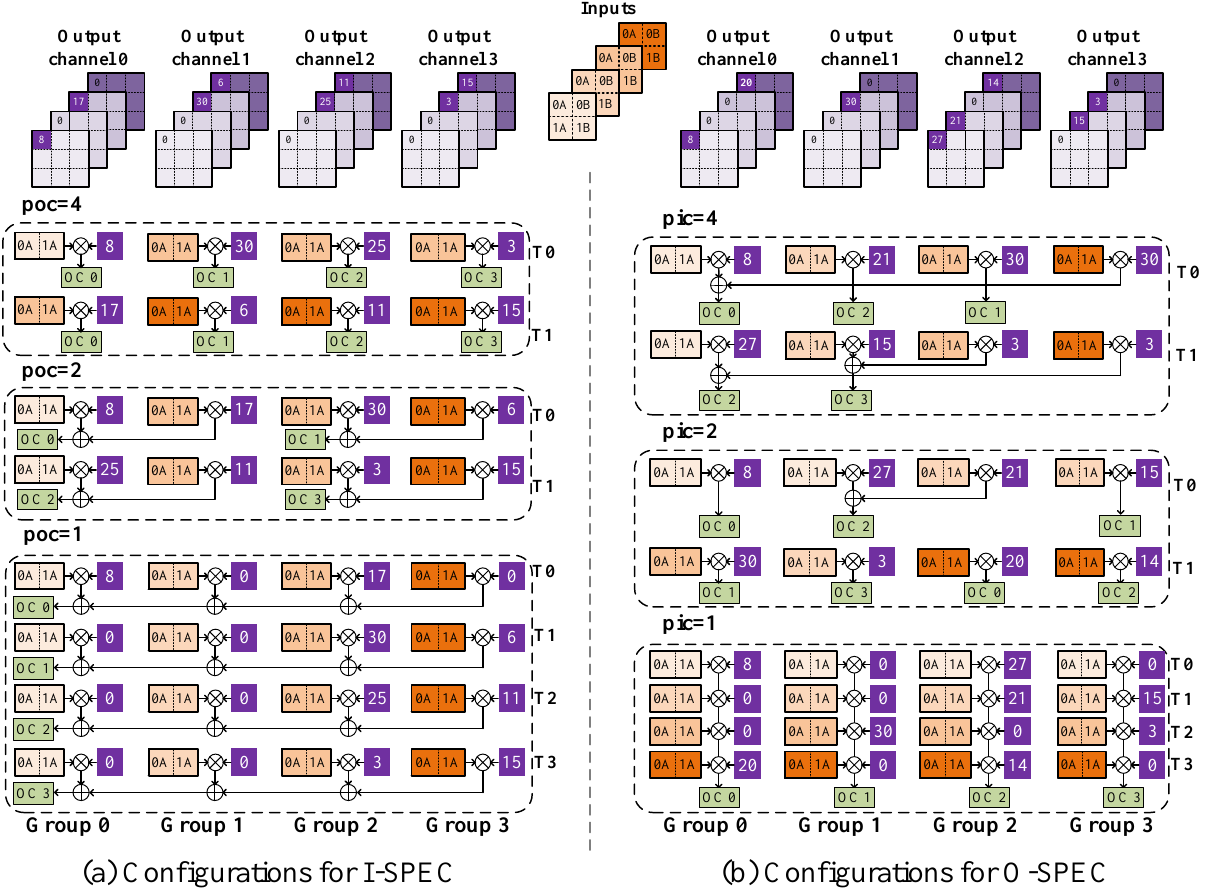
Figure 4. An example of SPECs with G = 4 under various configurations. The Tx in the figure denotes the processing cycles. Each multiplier illustrated as ‘x’ inside a circle denotes one group. ( a , b ) share the same inputs, which are shown in the top-middle of the figure and marked as Inputs. ( a ) shows three different configurations for I-SPEC. ( b ) shows three different configurations for O-SPEC.